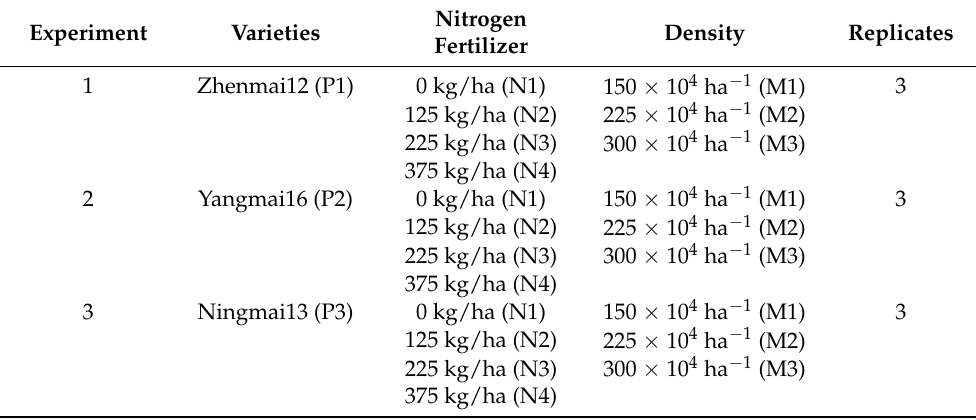
Table 1. Winter wheat varieties and nitrogen fertilizer and density treatments in three different experiments (Zhenmai12: Strong gluten wheat; Yangmai16: the gluten wheat; Ningmai13: Weak gluten wheat).”Replicates” represent three Replicates of the